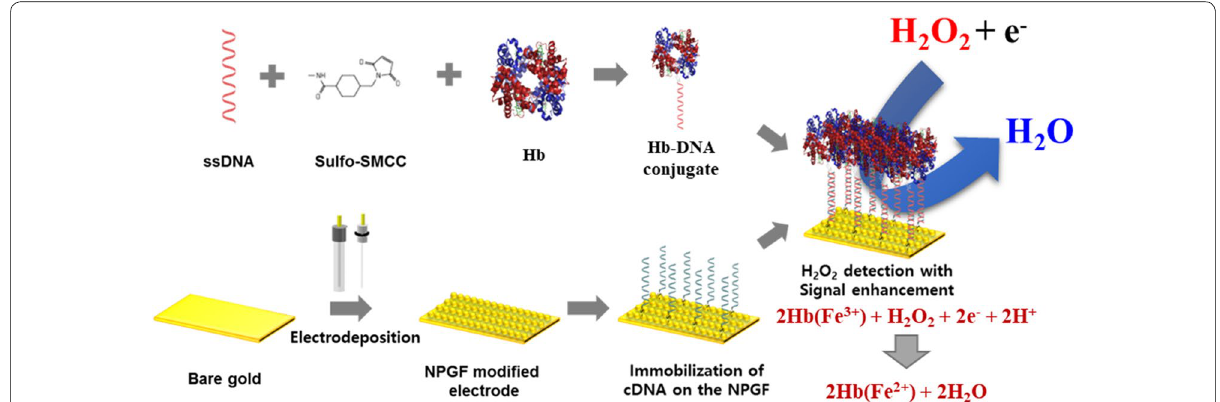
Fig. 1 The schematic diagram of Hb‑DNA conjugate on the NPGF